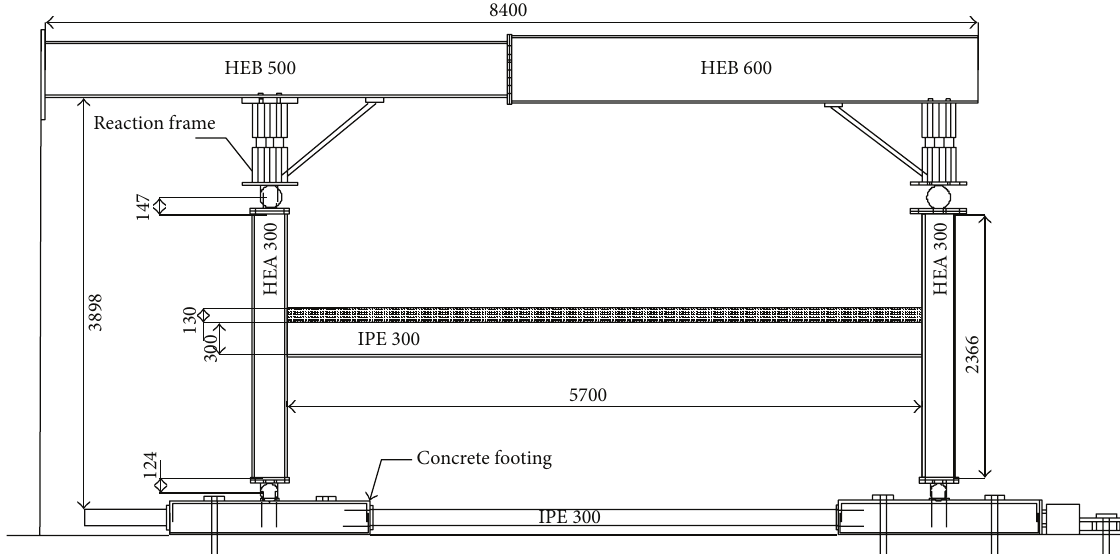
Figure 1: Laboratory sample